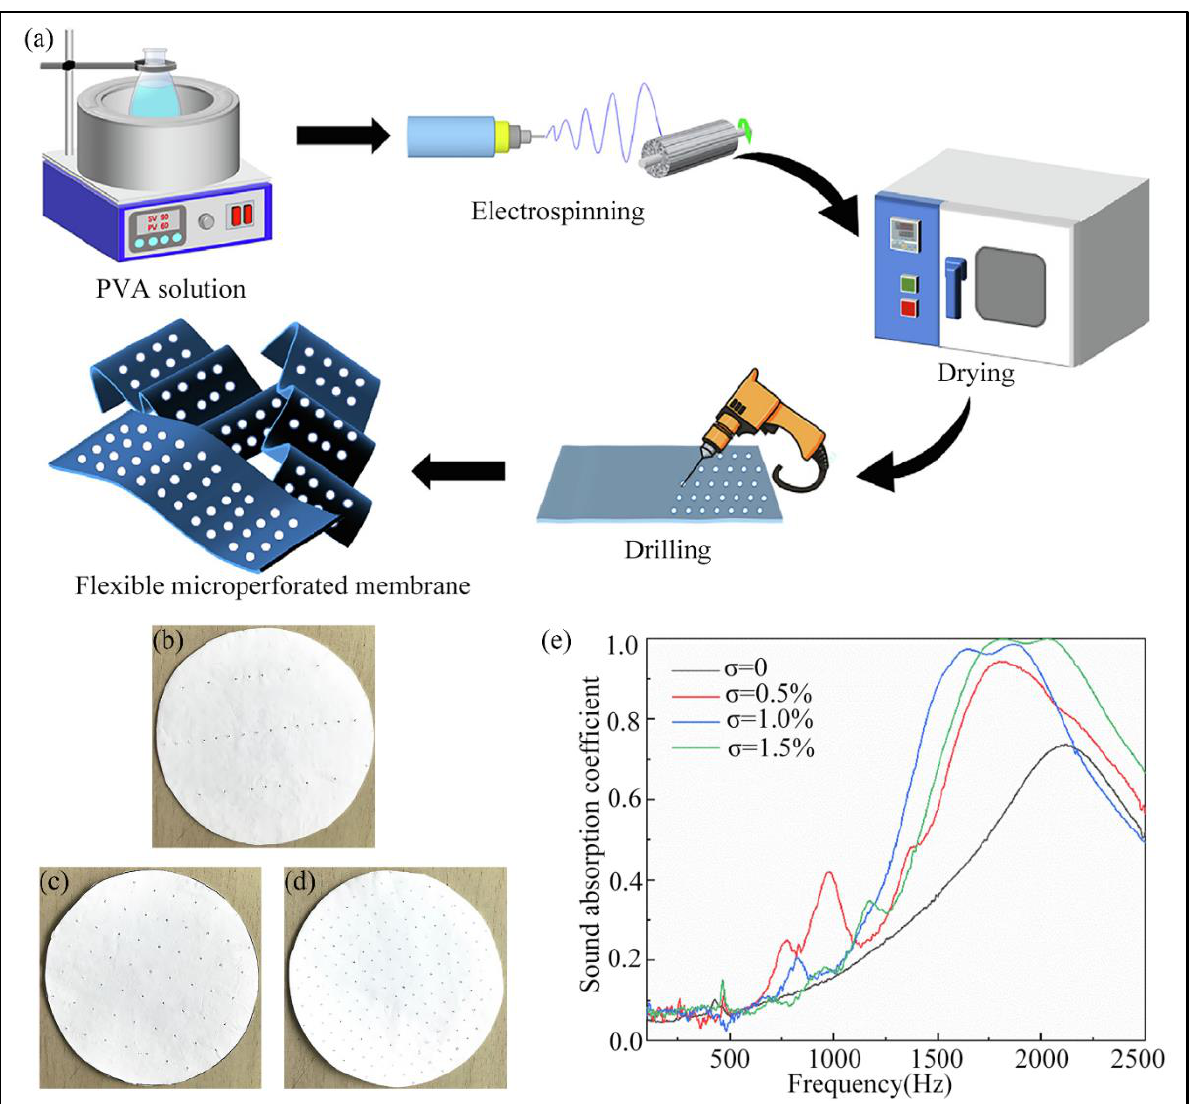
Figure 9. ( a ) The fabrication process of the flexible microperforated membrane; ( b – d ) Photographs of the microperforated samples with different perforation rates; ( e ) Sound absorption coefficient of the microperforated membranes with different perforation rates. Reprinted with permission from ref. [100]. Copyright 2022 Elsevier.